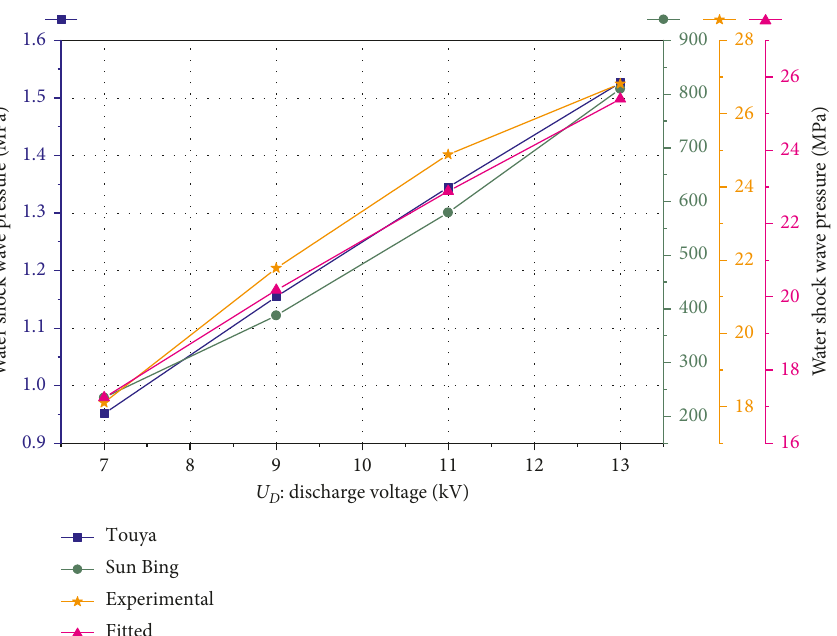
Figure 10: Comparative diagram showing the experimental U D versus the water shock peak pressure with the fitted curve and the data of Touya and Sun Bing, using P H of 0MPa and d of 1m.